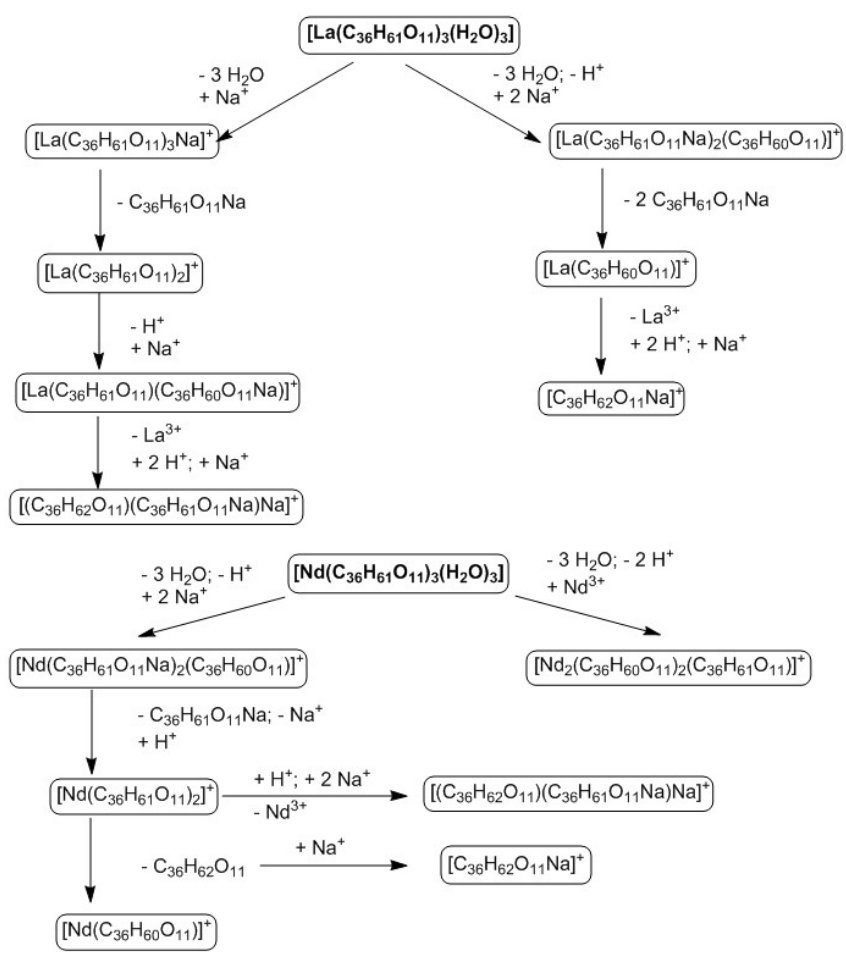
Scheme 2: Molecular fragmentation of 1 (above) and 2